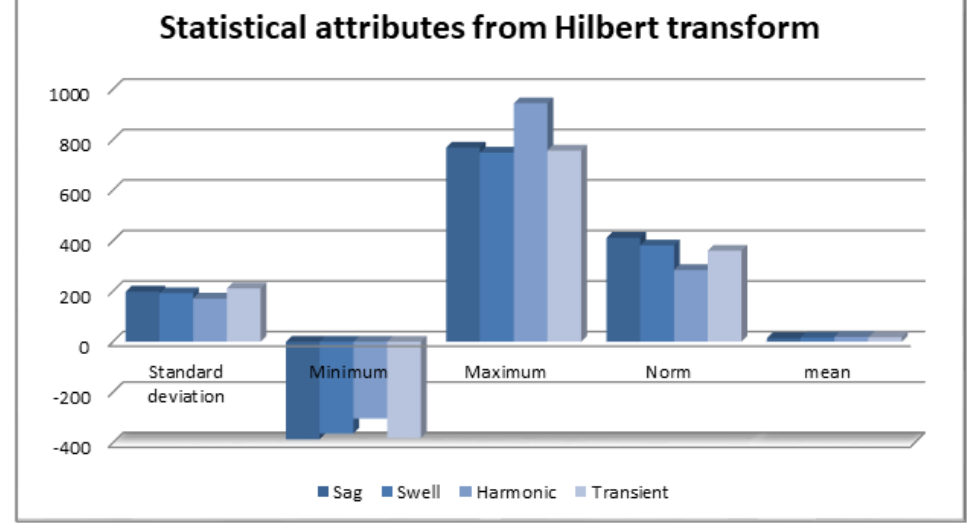
Figure 5. Values of different statistical attributes of Hilbert transforms for different